Question: What type of chart is this?
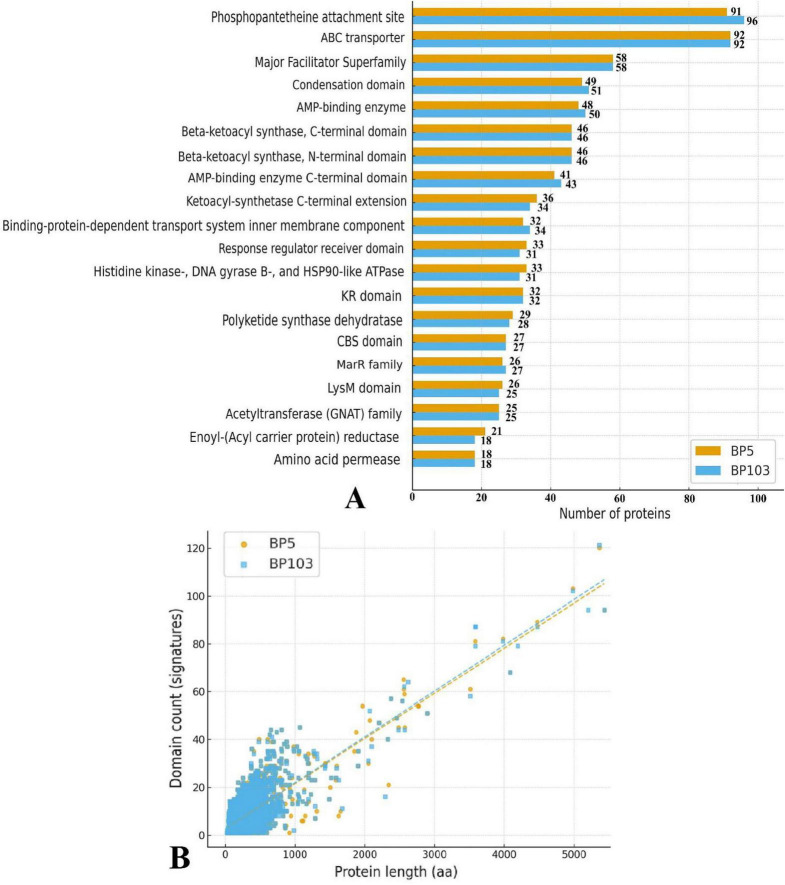
Answer: scatter